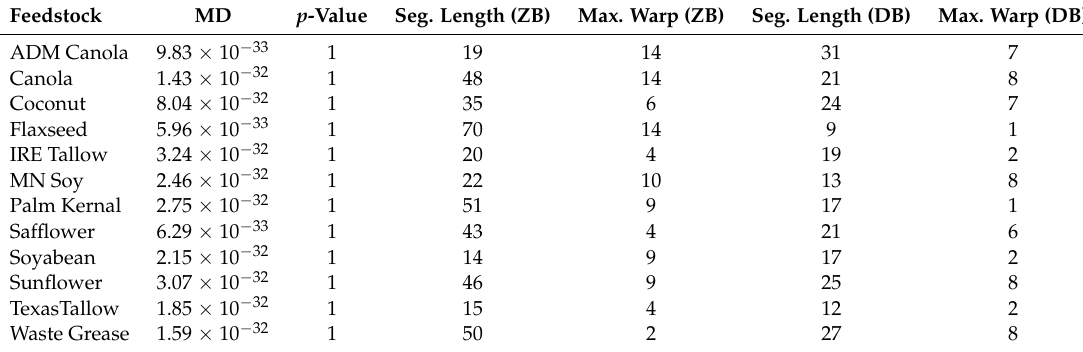
Table 1. Mahalanobis distance (MD), p -value, and optimal correlated optimized warping (COW) alignment parameters (segment length and maximum warp) for each feedstock, with alignment to a chromatogram from the same feedstock type chosen based on similarity index. The MD was computed based on L = 5